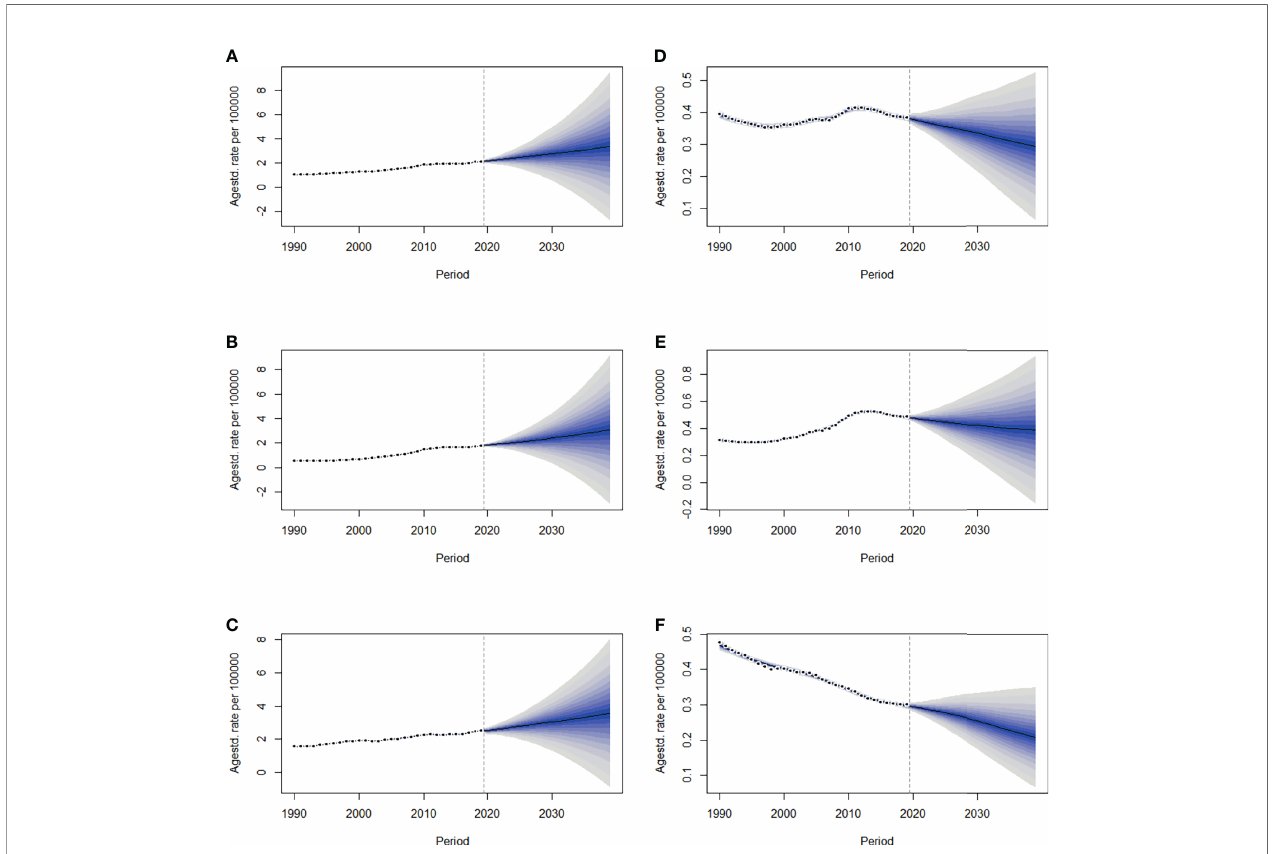
FIGURE 4 | The projections of ASIR (A – C) and ASMR (D – F) in total population, men and women of thyroid cancer from 2020 to 2039 in China. The open dots represent the observed values, and the fan shape denotes the predictive distribution between the 2.5 and 97.5% quantiles. The predictive mean value is shown as a solid line. The vertical dashed line indicates where the prediction starts. ASIR, age-standardized incidence rate; ASMR, age-standardized mortality